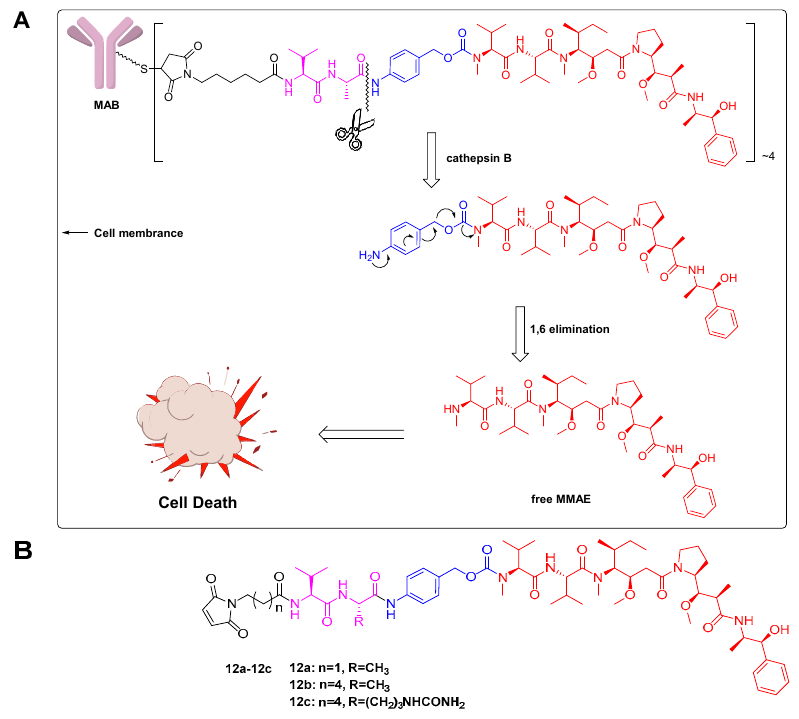
Figure 2. Linker design: ( A ) VA-based ADC with MMAE as the payload and its lysosomal processing. Upon internalization of ADC into the lysosomes of target cells, the amide bond between the alanine residue and the p-aminobenzylcarbamate (PABC) portion of the linker was cleaved by cathepsin B. Self-immolation of the PABC portion of the payload-linker via a 1,6-elimination process released free MMAE into the tumor cell, resulting in cell death; ( B ) Structure of the designed drug payload of MMAE-based ADCs: 12a – 12c .